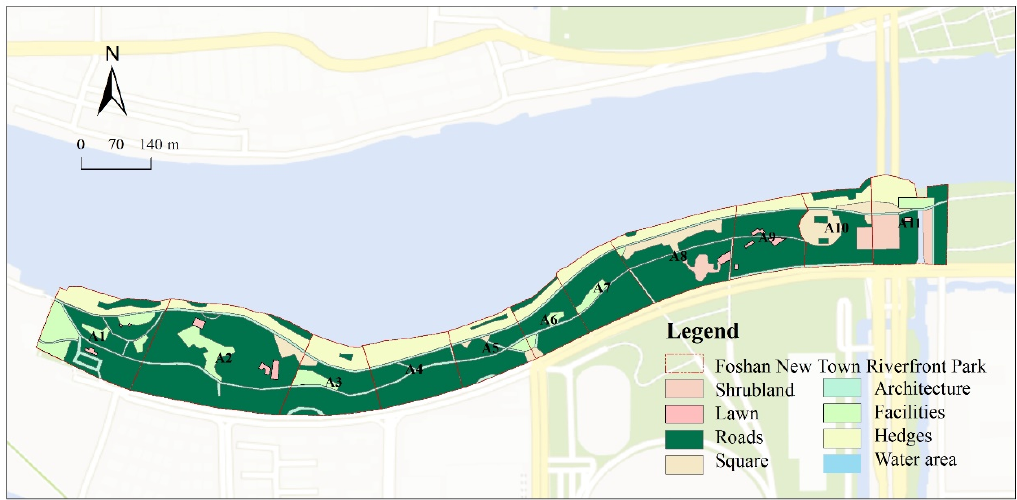
Figure 1. Landscape distribution map of New City Riverfront Park in Shunde District, Foshan City.